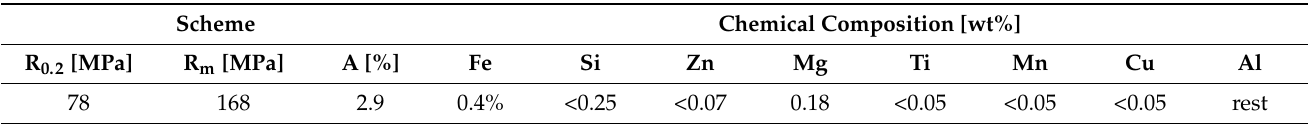
Table 3. Strength properties and chemical composition of the AA1050 alloy.